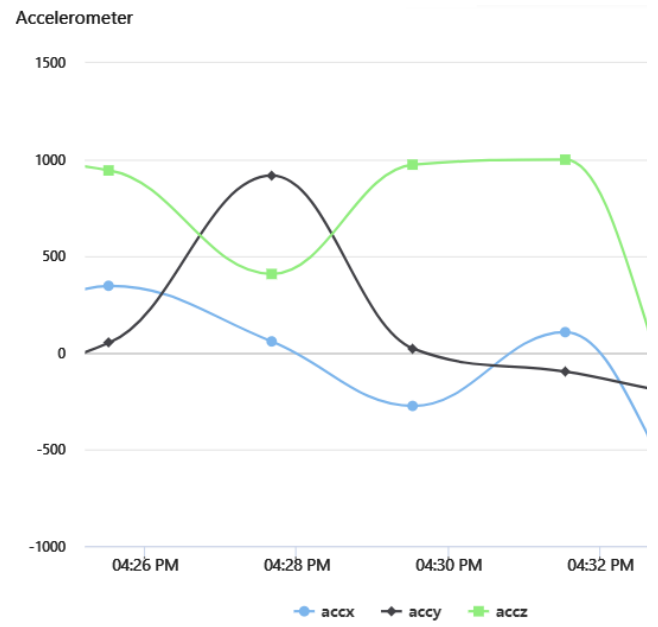
Figure 16. Accelerometer data changes received by